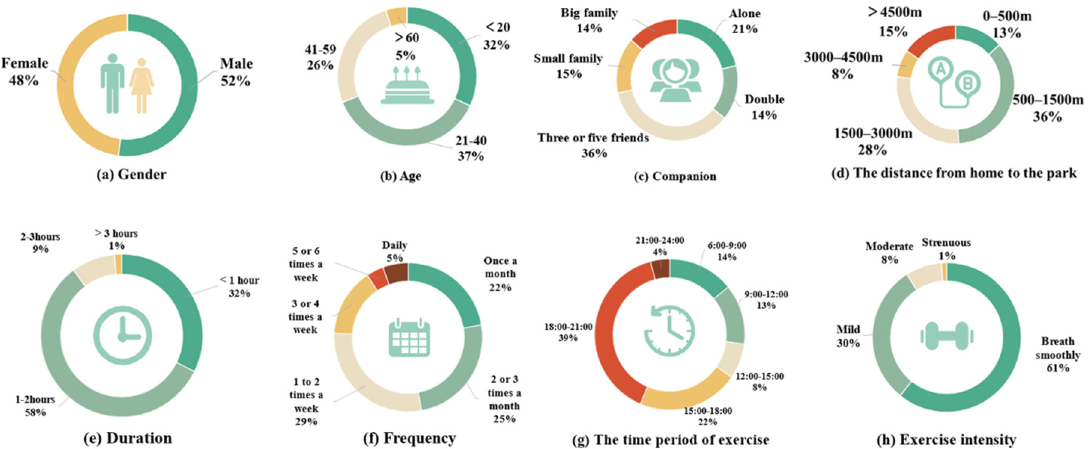
Figure 4. Statistical results of respondents’ personal characteristics ( a–h : gender, age, companion, the distance from home to the park, duration, frequency, and the time period of exercise and exercise intensity).